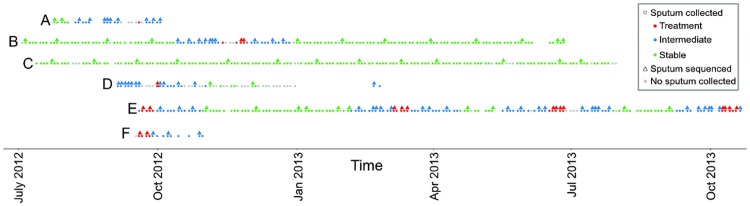
Outline of sputum collection and samples chosen for sequencing.Participants self-collected sputum 3 times a week while simultaneously recording clinical symptoms. On occasion, sputum could not or was not collected yet participant information was recorded (gray dots). Samples were retroactively chosen for microbiome analysis based on the sample type, aiming to follow Treatment more closely (1 sample/per 2–3 days) then Intermediate (1 sample per 1 week) and Stable (1 sample per 1 month) samples. All but one participant, C, experienced an exacerbation during the study period. Exact dates and length of sample collection for each participant is provided in S1 Table.